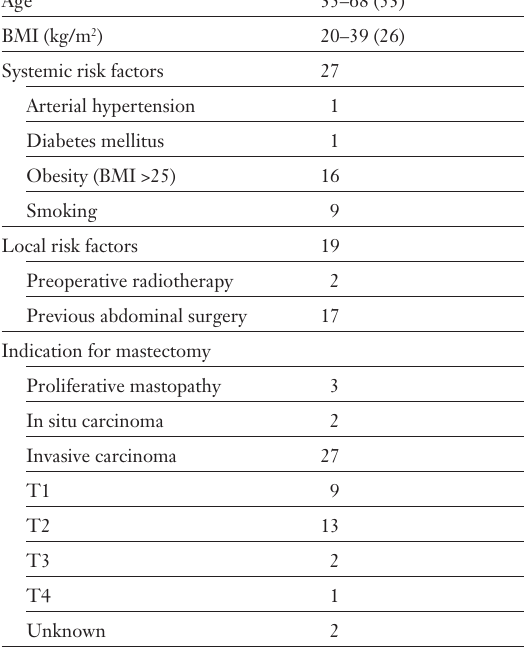
Patients’ data (n = 32 patients), range (median).